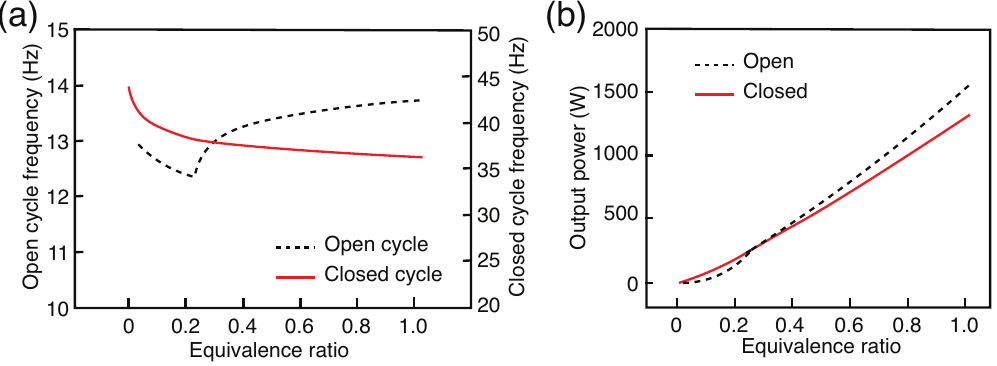
Figure 8. Performance metrics of the reference actuator in open and closed operating cycles: ( a ) Operating frequency and ( b ) Power